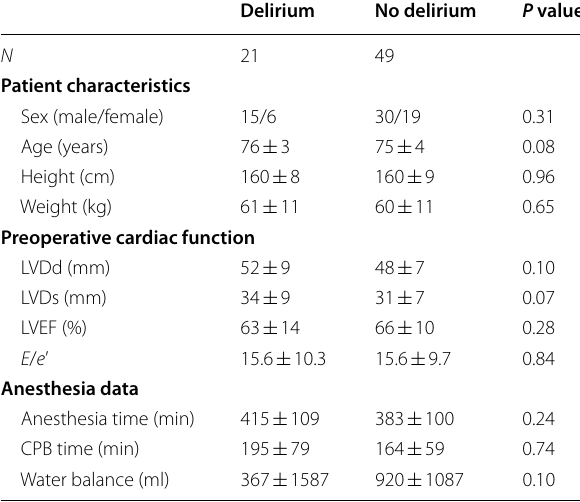
Table 2 Postoperative data in each group